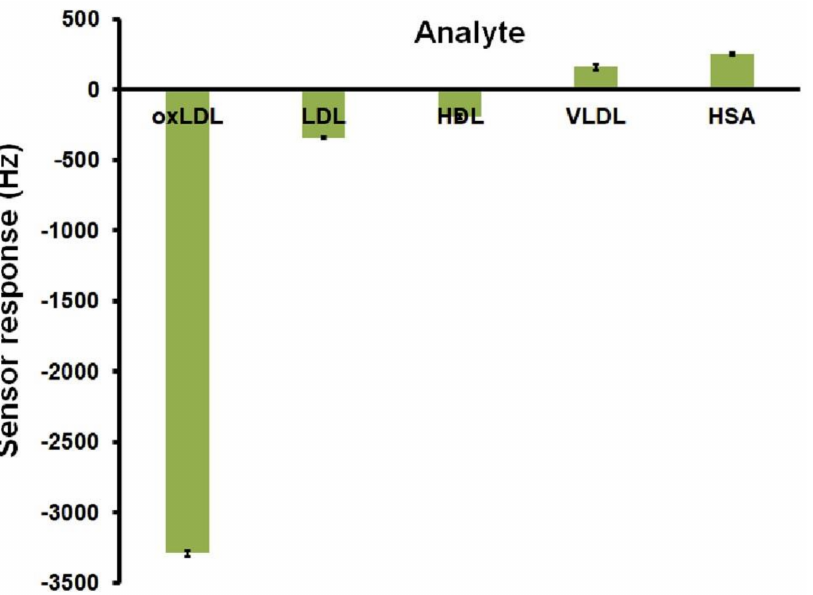
Figure 3. QCM signals obtained from selectivity measurements of the oxLDL-MIP in the presence of various (lipo) proteins at 200 mg/mL, reprinted with permission from [34], ©